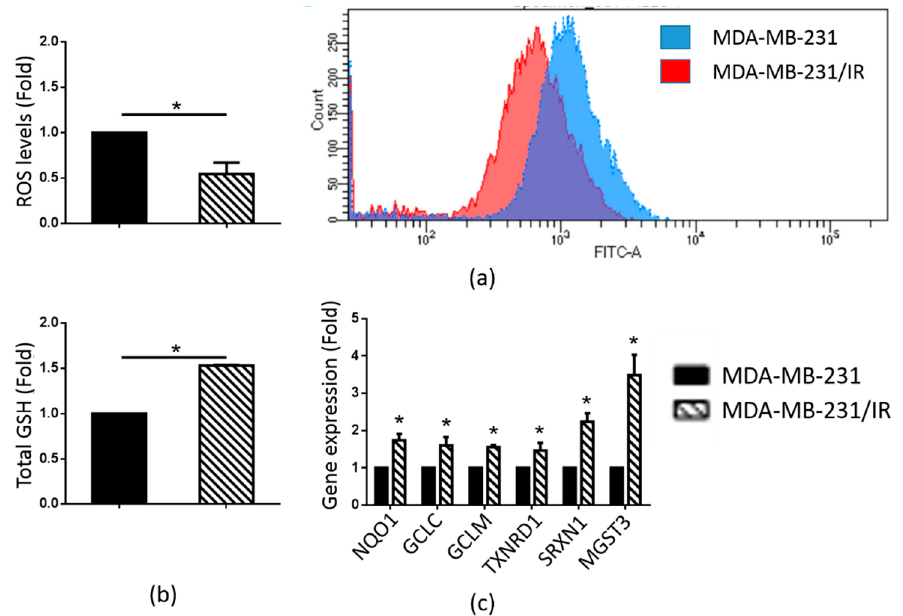
Figure 2. ROS and GSH levels and expression of genes related to antioxidant effects in MDA-MB-231 and MDA-MB-231 / IR cells. ( a ) ROS levels were evaluated after staining with H 2 DCFDA. ( b ) Total glutathione levels were measured by the GSH assay. ( c ) The expression of antioxidant-related genes was analyzed by real-time PCR; * p < 0.05; results are presented as mean ± standard deviation.